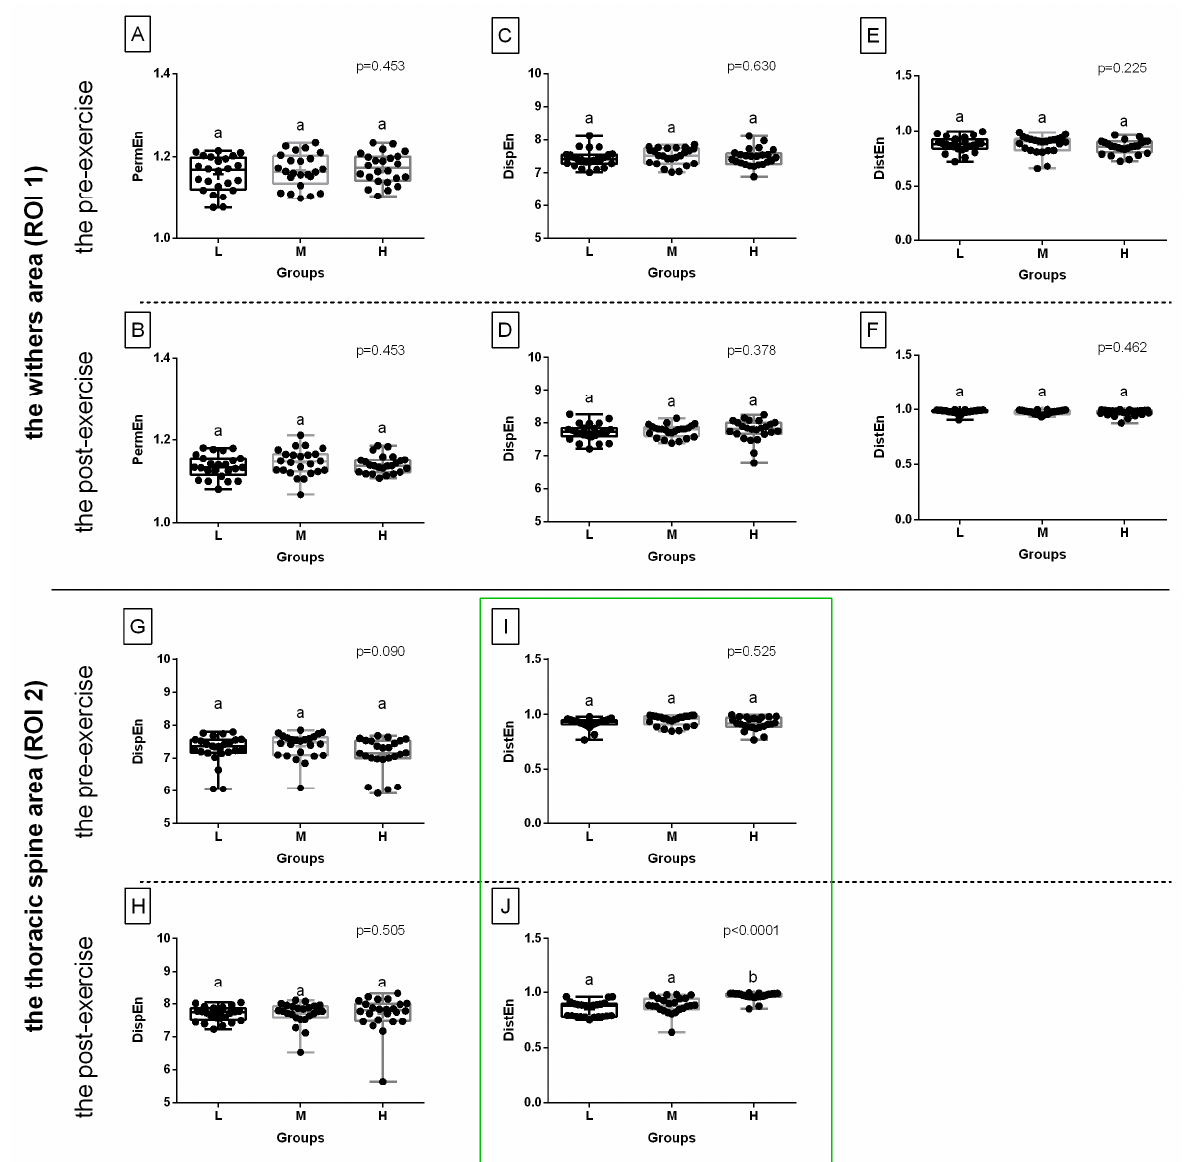
Figure 4. The comparison of the selected entropy measures in the green color component between light (L), moderate (M), and heavy (H) rider groups. The withers area (ROI 1) ( A – F ) and the thoracic spine area (ROI 2) ( G – J ) are separated by a solid horizontal line. The images obtained pre-exercise ( A , C , E , G , I ) and post-exercise ( B , D , F , H , J ) are separated by dashed horizontal lines. The following entropy measures are considered: PermEn—two-dimensional permutation entropy ( A , B ), DispEn— two-dimensional dispersion entropy ( C , D , G , H ), DistEn—two-dimensional distribution entropy ( E , F , I , J ). Data are presented using minimum and maximum values, lower and upper quartiles, and median. The mean value is marked by a cross. Differences between rider groups were indicated with individual p -values when p < 0.05. Different superscripts on each plot were statistically different. Measures that differ between rider groups (L, M, H) are marked with a green